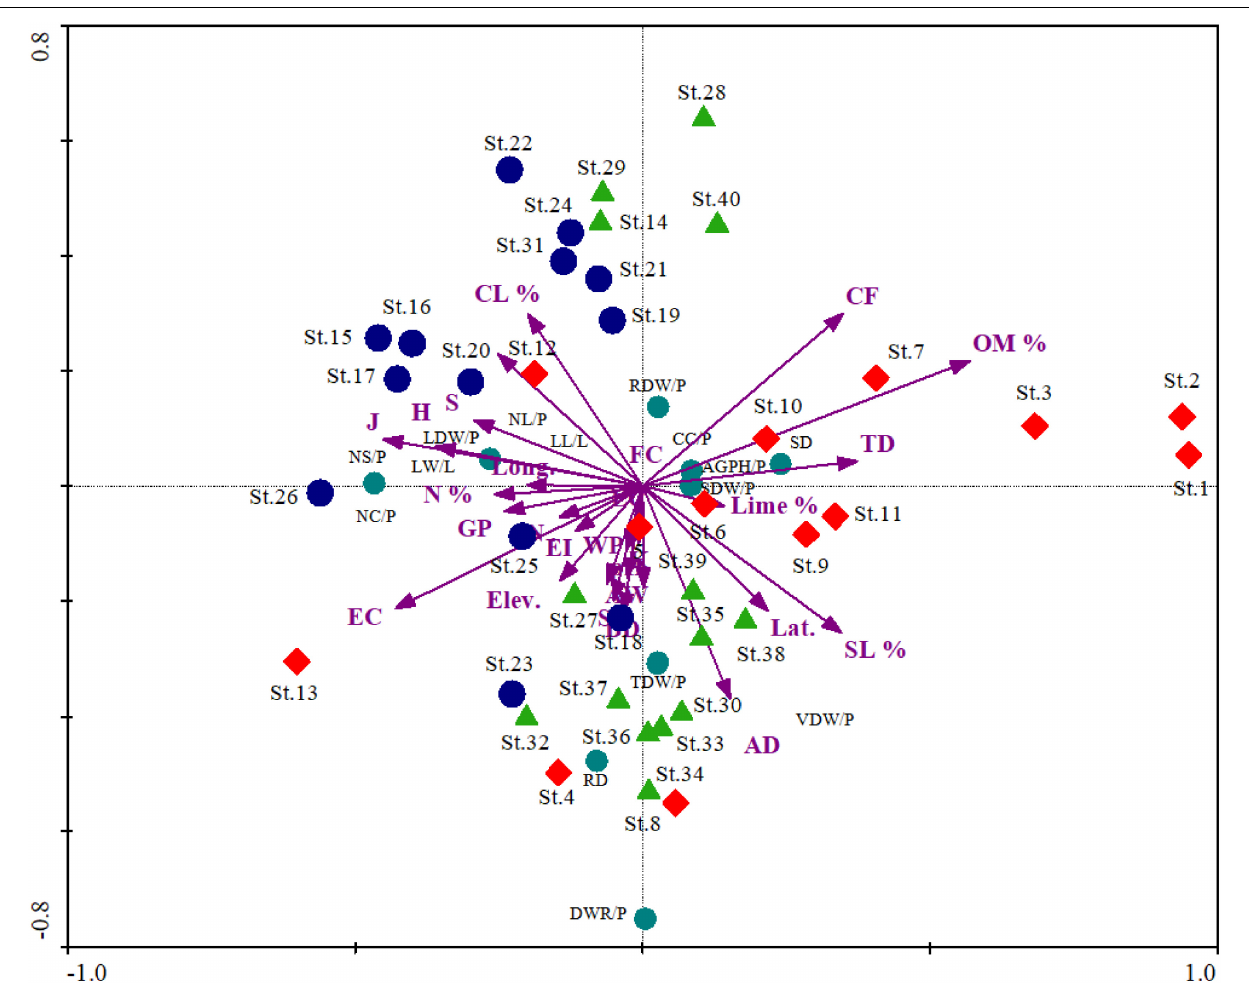
FIGURE 5 | Redundancy analysis biplot showing the distribution pattern of sites and different morphological and biomass traits. St (Site number): The rest of the captions are the same as that mentioned in Tables 1–3